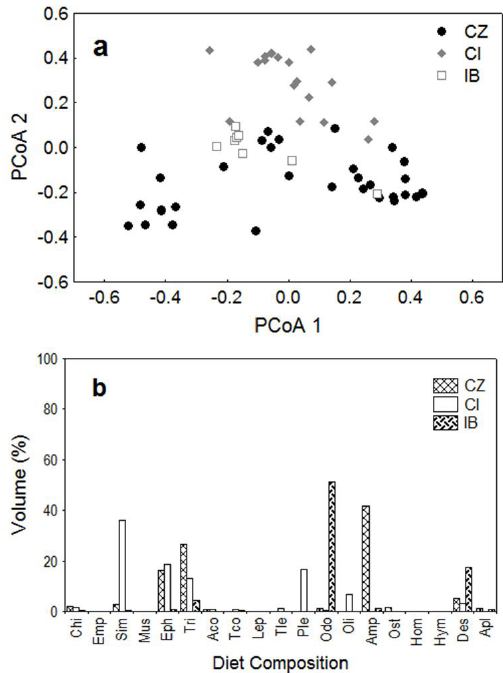
Figure 2. Diet data ordination (using the first two axes of PCoA, that explained 42% of the data variance) (a) and diet composition (b) of fish species sampled in the Remo stream. CZ= C. zebra ; GI = G. inaequilabiatus; TD = T. diabolus; Chi= Chironomidae; Cer= Ceratopogonidae; Emp= Empididae; Sim= Simuliidae; Psy= Psychodidae; Tip= Tipulidae; Mus= Muscidae; Eph= Ephemeroptera; Tri= Trichoptera; Aco= aquatic Coleoptera; Tco= terrestrial Coleoptera; Lep= aquatic Lepidoptera; Odo= Odonata; Amp= Amphipoda; Ost= Ostracoda; Ara= Araneae; Des= detritus/sediment; Apl= aquatic plants.